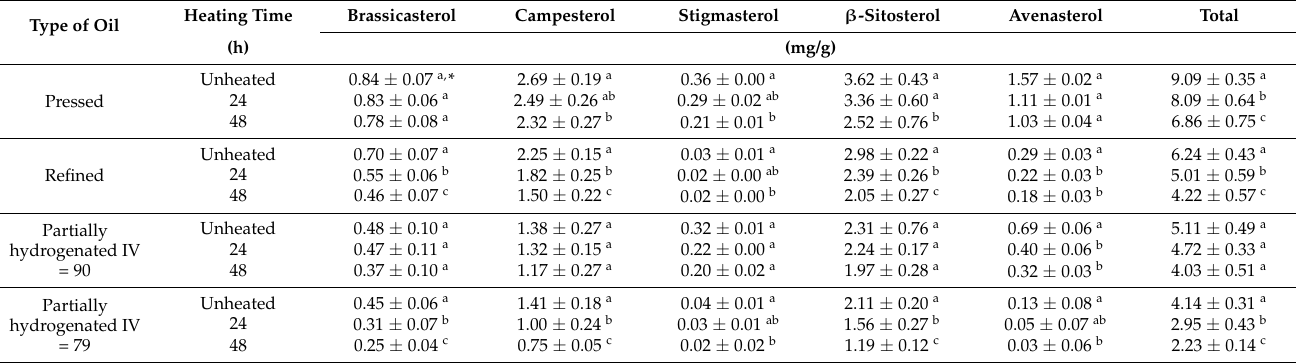
Table 2. Influence of heating time on the phytosterol contents in rapeseed oil heated at 170 ± 5 ◦